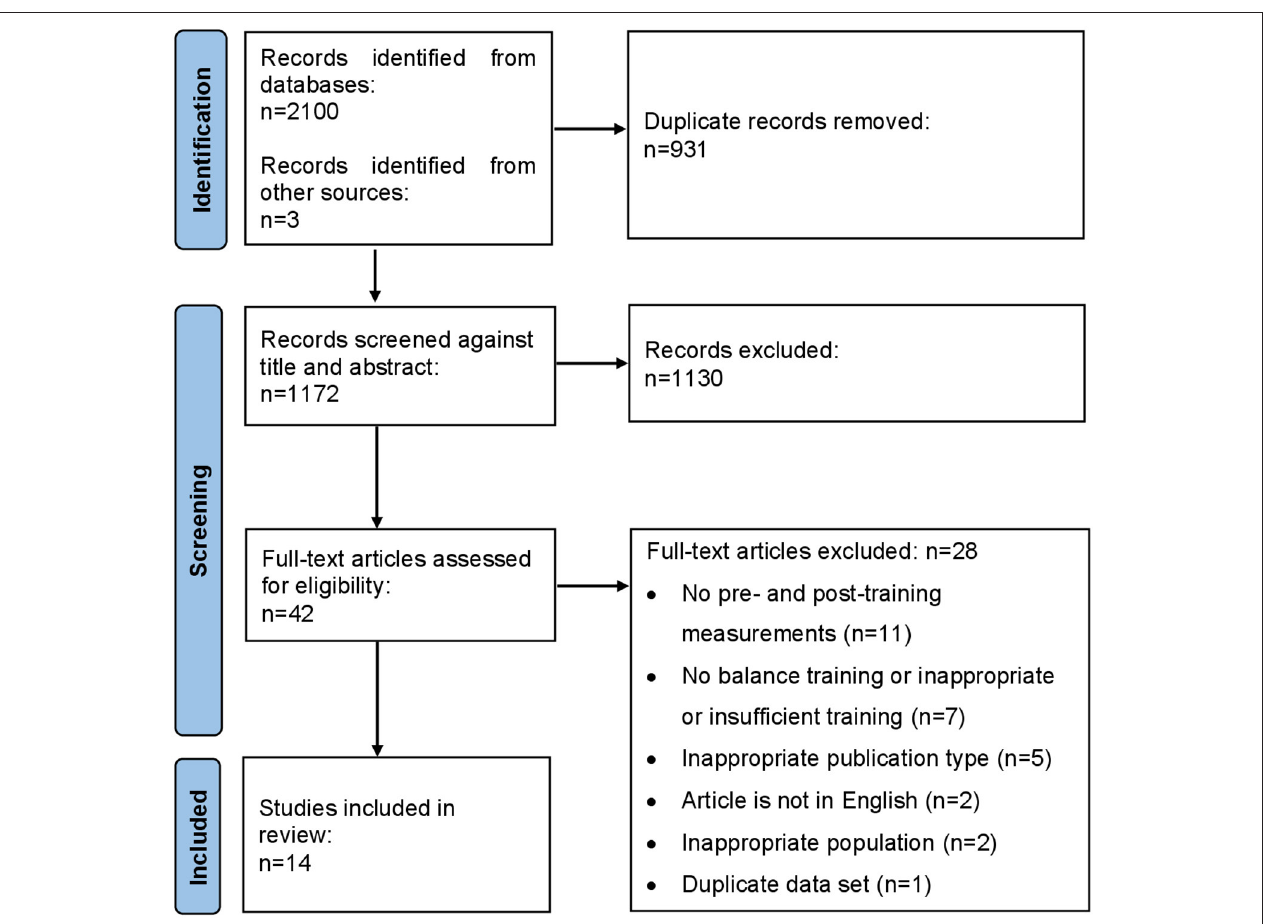
FIGURE 1 | Flowchart of systematic search and article inclusion and exclusion